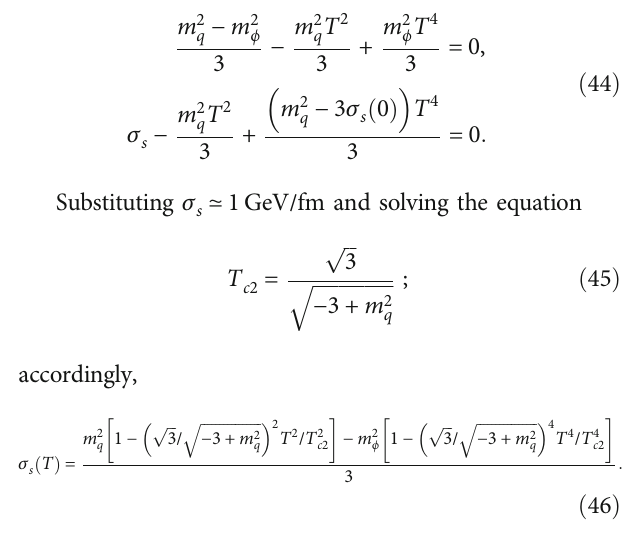
q(cid:6) ffiffiffi ffiffiffiffiffiffiffiffiffiffiffiffiffiffiffiffi ffiffiffi p 3 / − 3+ m 2